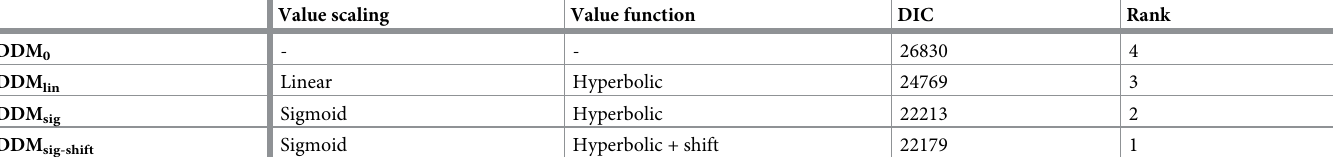
Table 2. Model comparison of the variants of the drift diffusion models of temporal discounting using absolute values.